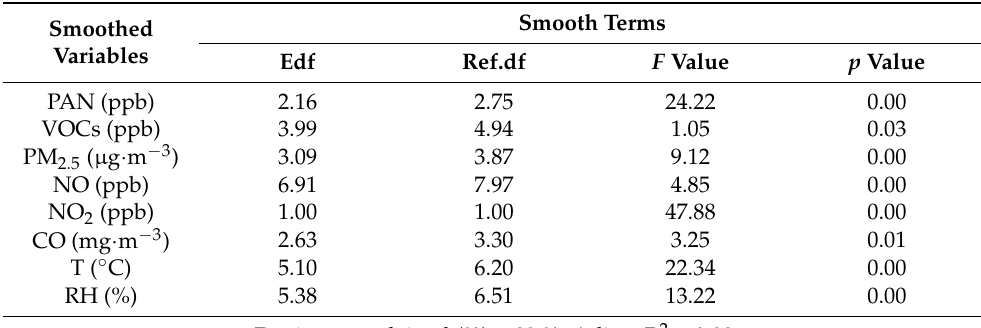
Table 2. The results for each variable in the GAM based on monitoring data for the full year in 2021 (estimated degrees of freedom (Edf), degree of reference (Ref.